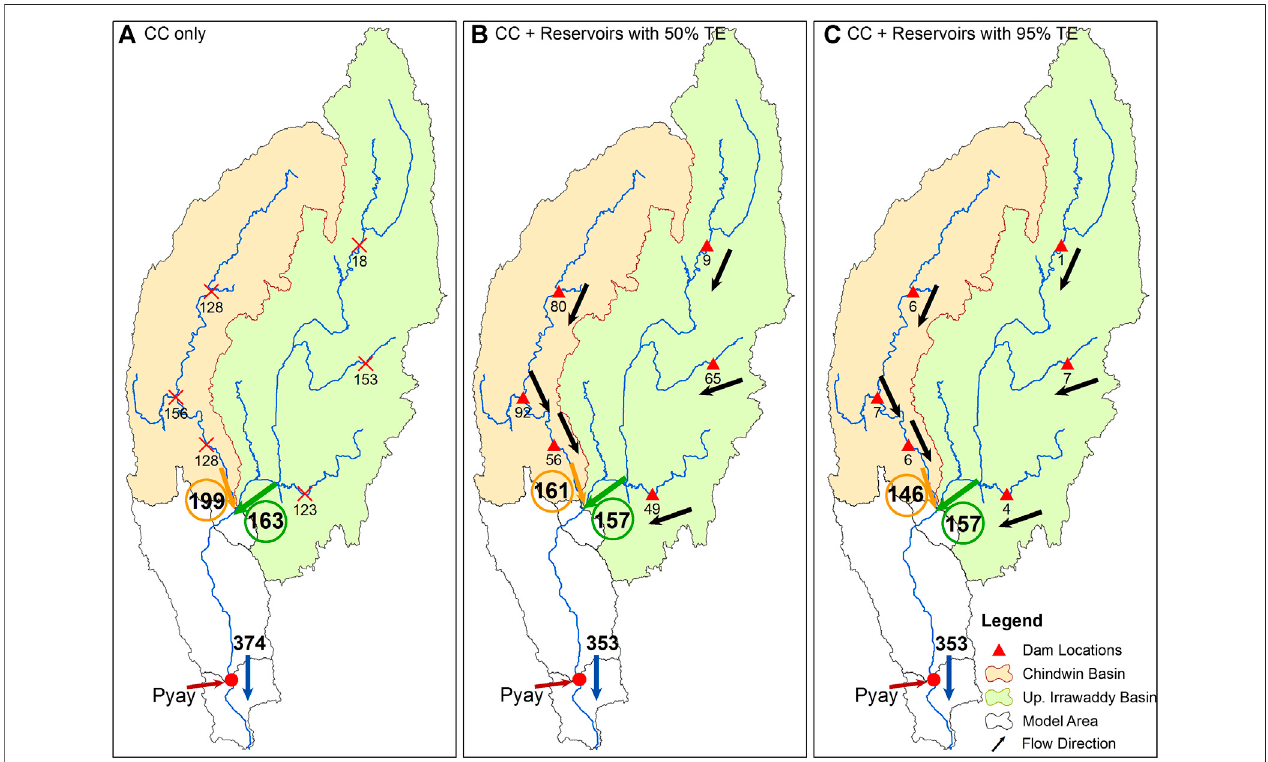
FIGURE 6 | Projected mean annual sediment loads (in MT/yr) in different reservoir reaches (just downstream of reservoirs) from simulations forced with CSIRO Mk3.6 under RCP 8.5 with (A) climate change only (B) climate change and reservoirs with 50% trapping ef fi ciency, and (C) climate change and reservoirs with 95% trapping ef fi ciency for 2081 –